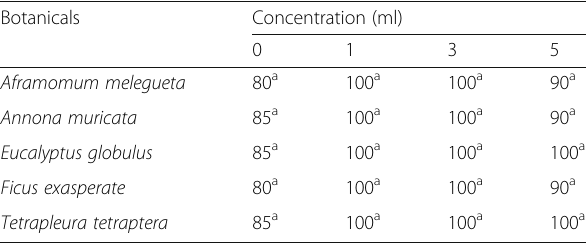
Table 5 Effect of essential oils on the germination of cowpea seeds after 120 days